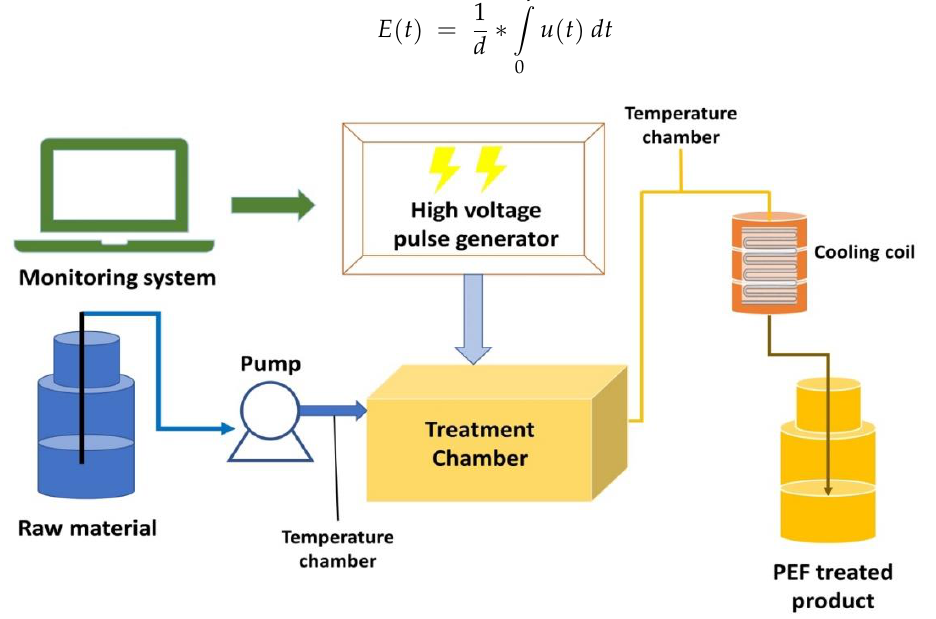
Figure 1. Diagram of a possible continuous PEF device used to treat food samples.